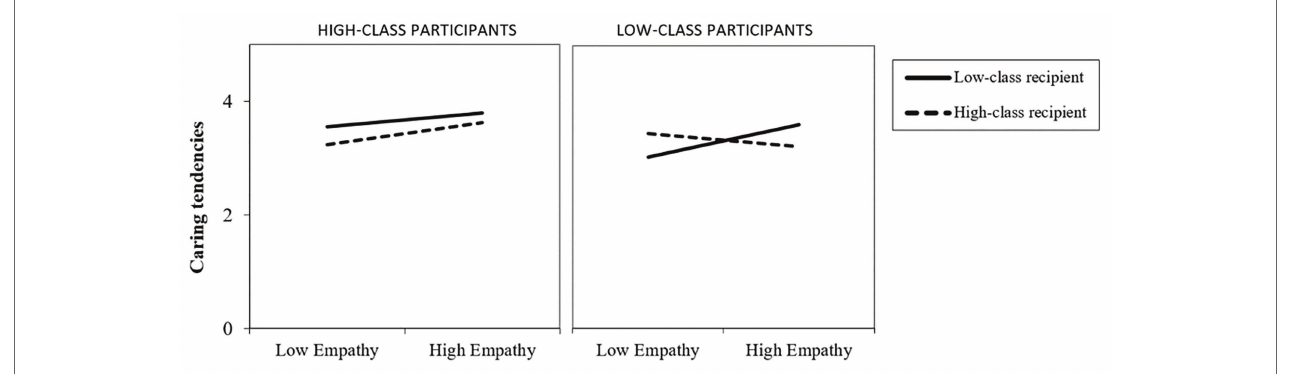
FIGURE 2 | Participant’s caring tendencies by high and low levels of empathy, as a function of the social class of the recipient of